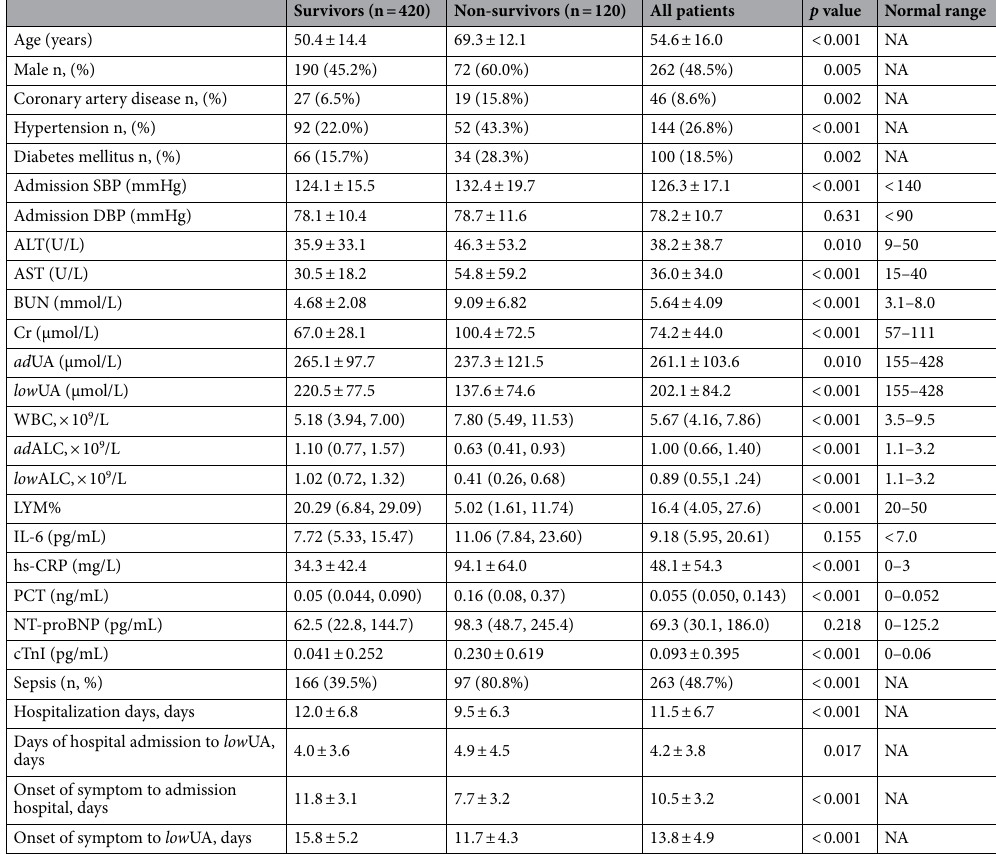
Table 1. Baseline characteristics of patients with severe COVID-19 pneumonia. ad ALC, admission absolute lymphocyte count; low ALC, the lowest level of ALC during hospitalization; ALT, alanine aminotransferase; AST, aspartate aminotransferase; BUN, blood urea nitrogen; Cr, creatinine; cTnI, cardiac troponin I; DBP, diastolic blood pressure; hs-CRP, high-sensitivity C reactive protein; IL-6, interleukin-6; LYM%, Lymphocyte percentage; NT-proBNP, N-Terminal pro-brain natriuretic peptide; PCT, procalcitonin; SBP, systolic blood pressure; ad UA, admission uric acid; low UA, the lowest level of uric acid during hospitalization; WBC, white blood